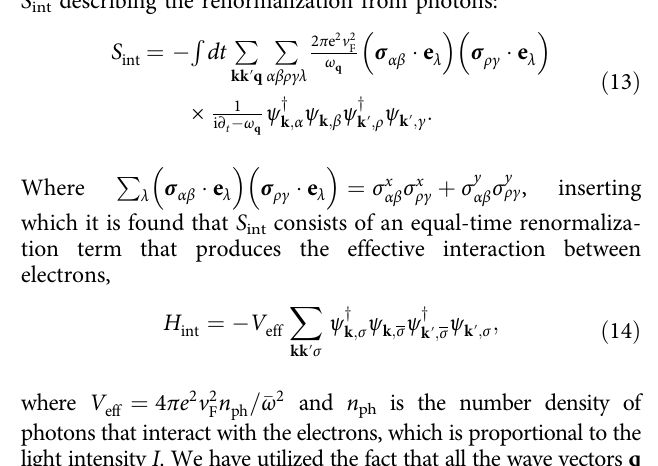
Fig. 4 The results from mean- fi eld calculations. a Condensation energy versus interaction V for p + ip excitonic insulator and polar excitonic insulator. b Calculated mean- fi eld excitonic order parameter for p + ip excitonic insulator ( Δ c ) and polar excitonic insulator ( Δ p ) versus interaction V . Δ is assumed. c The phase diagram based on unbiased mean- fi eld with considering both the s - and p + ip -wave interaction channel. The dash-dotted red line denotes the Hubbard interaction case with V s = V